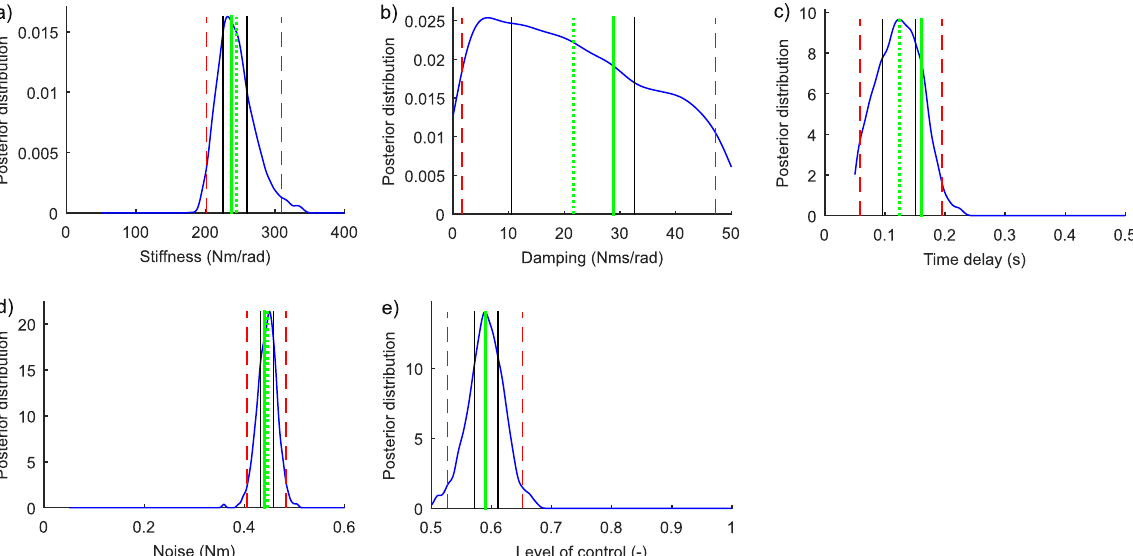
Figure 4. Marginal posterior probability density functions of the five parameters: ( a ) Stiffness, P ; ( b ) Damping, D ; ( c ) Time delay, Δ ; ( d ) Noise, σ ; and ( e ) Level of control, C ON . Vertical lines present true parameter values (green, thick), estimated parameter values (green, dotted), 50% CIs (black, solid), and 95% CIs (red, dashed). These results are from the same simulated test subject as in the rightmost panel in Fig. 3. The ranges on the x-axes correspond to the ranges of the prior distribution.